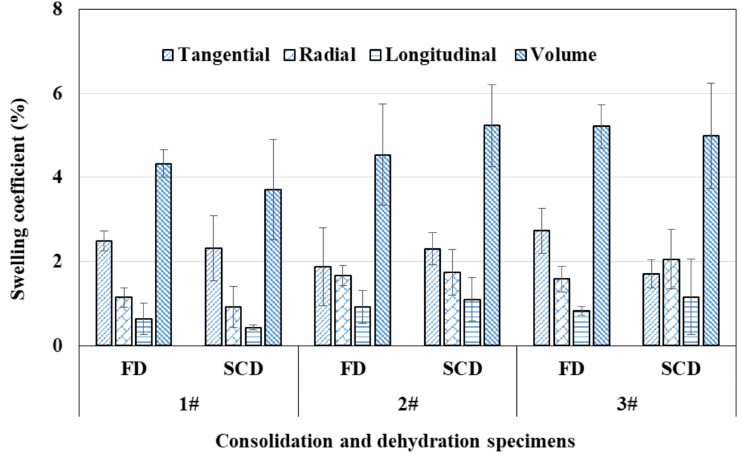
Figure 4. Swelling coefficients of specimens from different